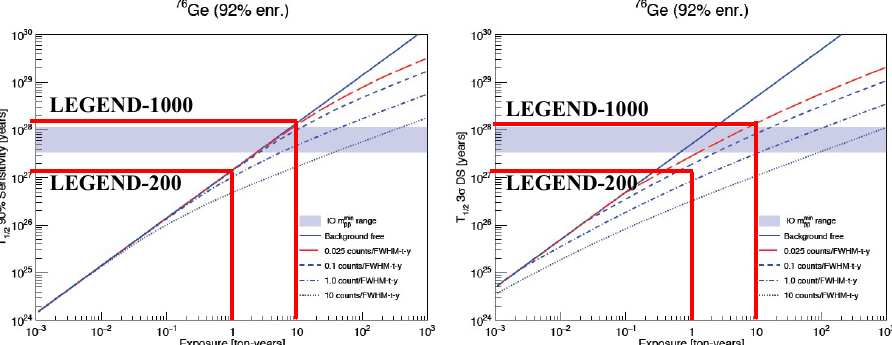
Figure 12. Sensitivity as a function of exposure and background for an isotopic enrichment fraction in 76 Ge of 92% and for ( left ) a 90% C.L. limit setting and ( right ) a 3 σ signal discovery. Plots from